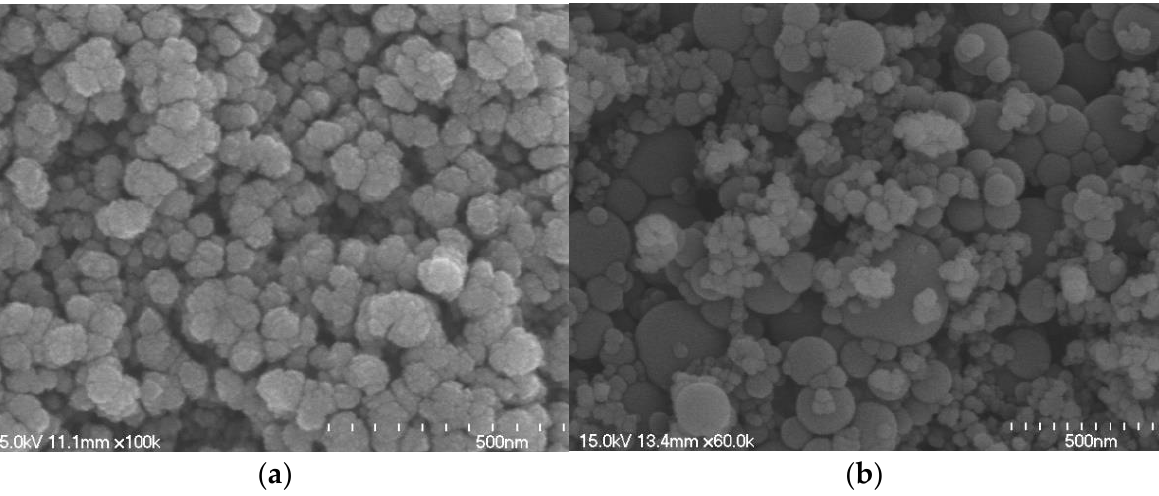
Figure 3. SEM images of ( a ) NS solution (×100,000) and ( b ) mixed NS/SF (NSF) solution (×60,000).